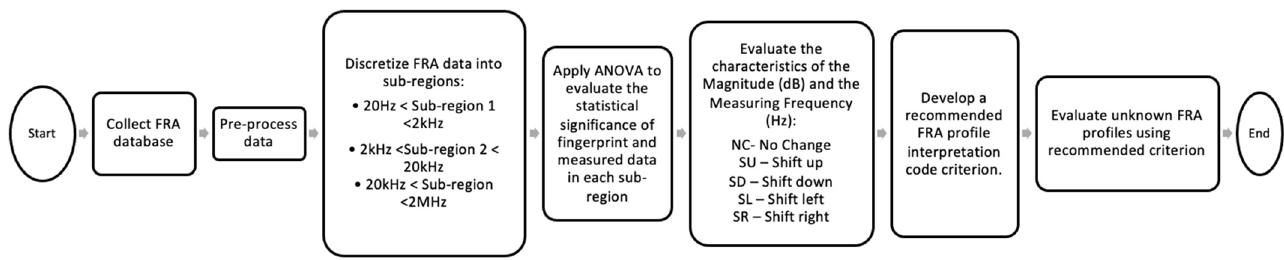
Figure 1. Formulation of the proposed methodology.